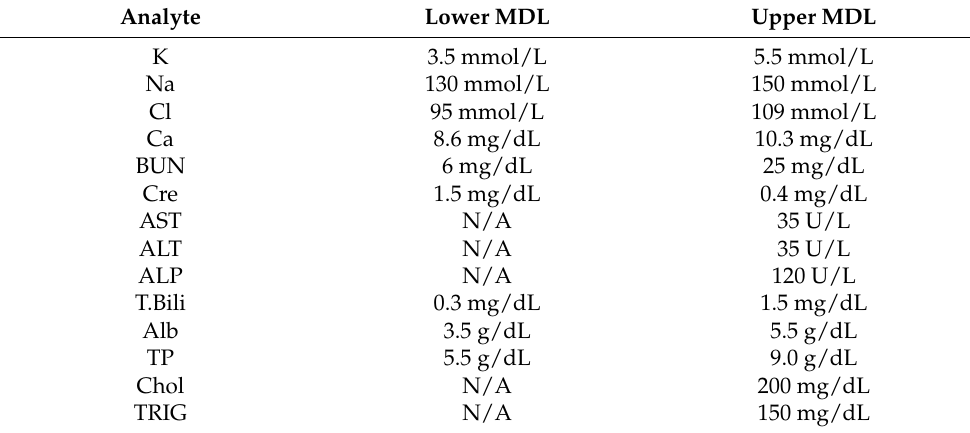
Table 1. Primary upper and lower medical decision limits as applicable for all analytes tested. Analyte Lower